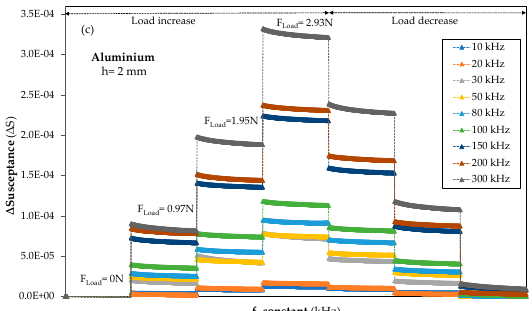
Figure 5. ∆ S loading and unloading results (from F = 0 N to 3 N) measured on the time domain from 10 kHz to 300 kHz frequencies for ( a ) Steel specimen with h = 2 mm thick, ( b ) Steel sample with h = 3 mm thick, ( c ) Aluminium specimen with h = 2 mm thick.